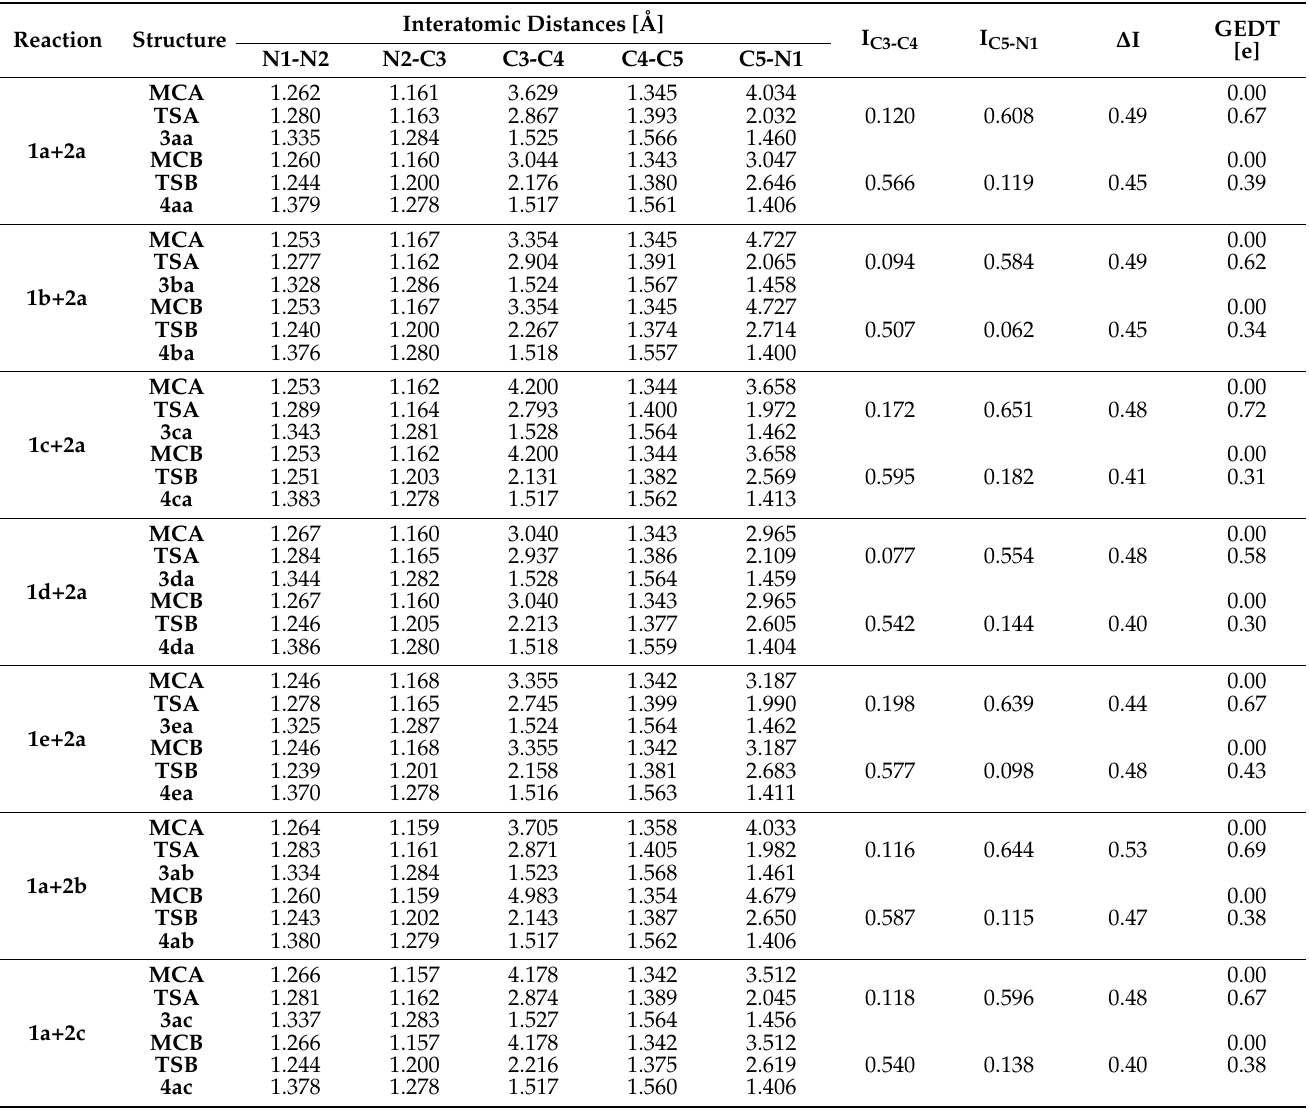
Table 4. Selected parameters for the key structures of the 32CAs of diarylnitrylimines 1a – e and ACNs 2a – c , in toluene, obtained from DFT